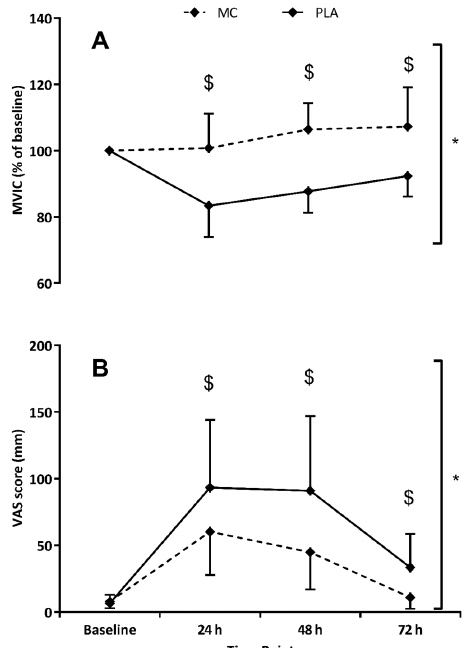
Figure 2. Changes in maximum voluntary isometric contraction (MVIC; Panel ( A )) and delayed onset muscle soreness (DOMS; Panel ( B )) in response to Montmorency cherry (MC) or placebo (PLA) supplementation. * Group effect; $ Interaction effect ( p < 0.05).